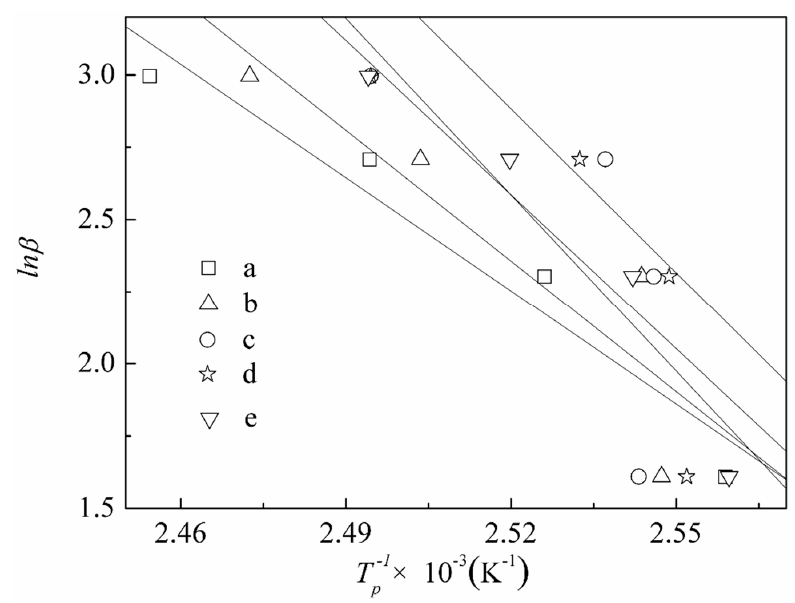
Figure 10. Linear fitting charts of ln β versus 1/ T p (( a ) 0%; ( b ) 5%; ( c ) 10%; ( d ) 15%; ( e ) 20%).